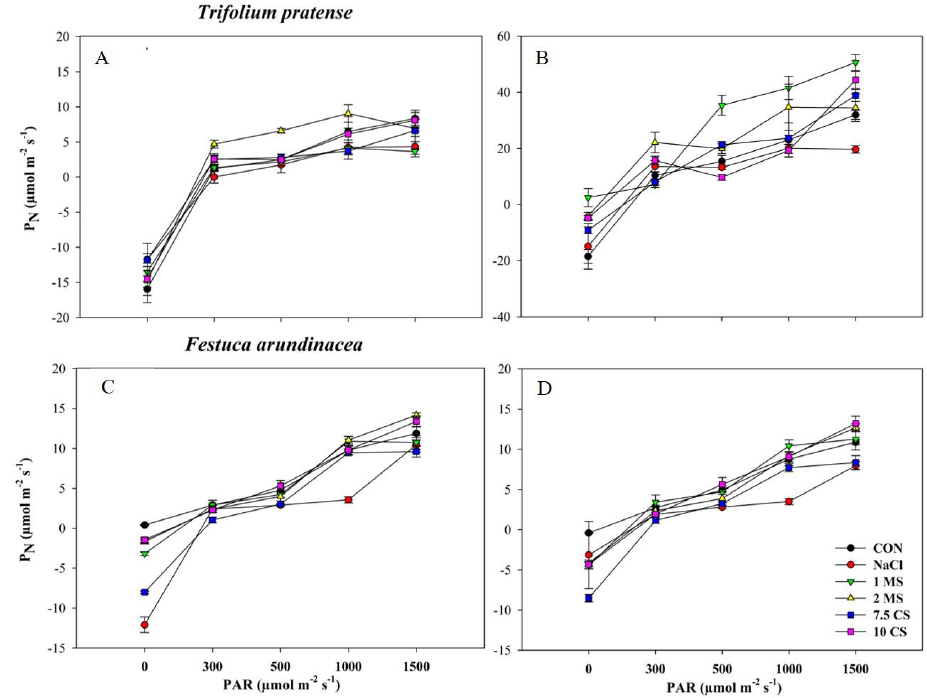
Figure 4. Photosynthetic rates of six different treatments under 400 μmol·mol − 1 CO 2 at the PAR value from 0 to 1500 µmol·m − 2 s − 1 with the air ambient temperature. ( A ) 60 DAT; ( B ) 120 DAT in T. pratense ; ( C ) 60 DAT; ( D ) 120 DAT in F. arundinacea . Vertical bars represent standard errors ( N = 4).